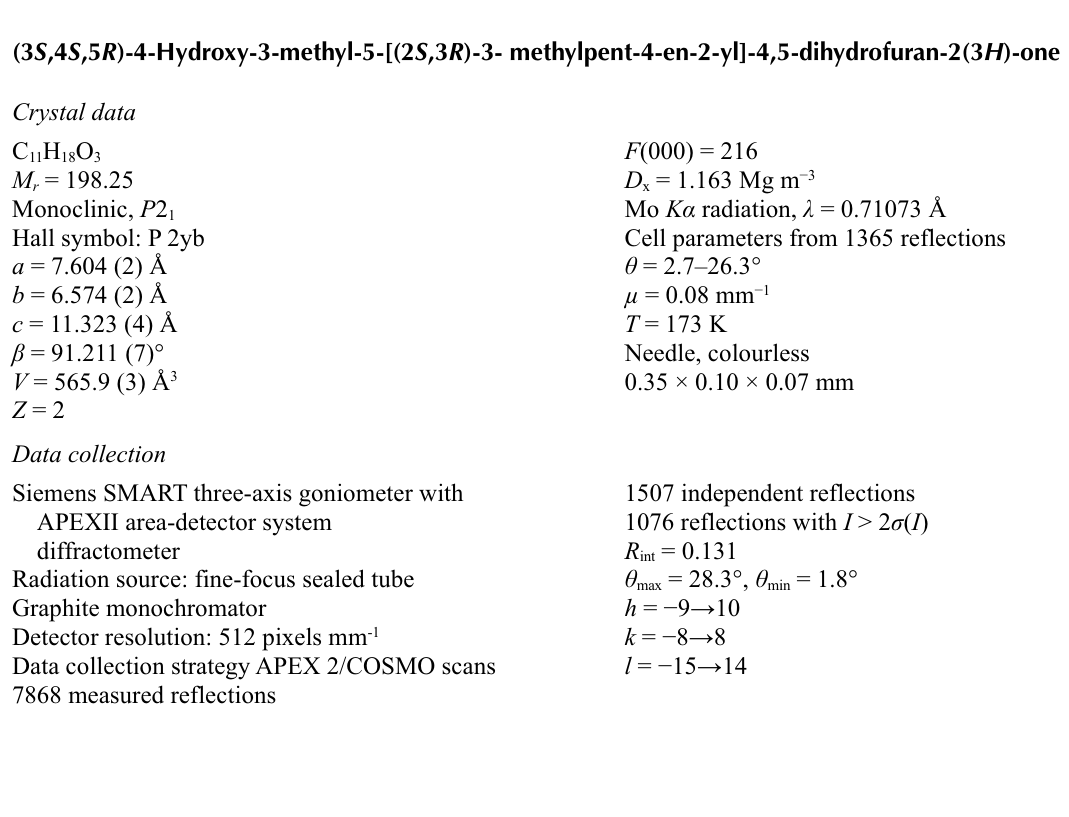
The molecular structure of (I) with displacement ellipsoids for the non-hydrogen atoms shown at the 30% probability